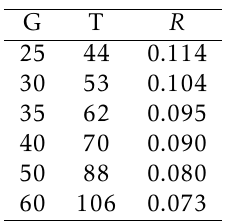
Table 7. Some statistics for rally point system with various goal